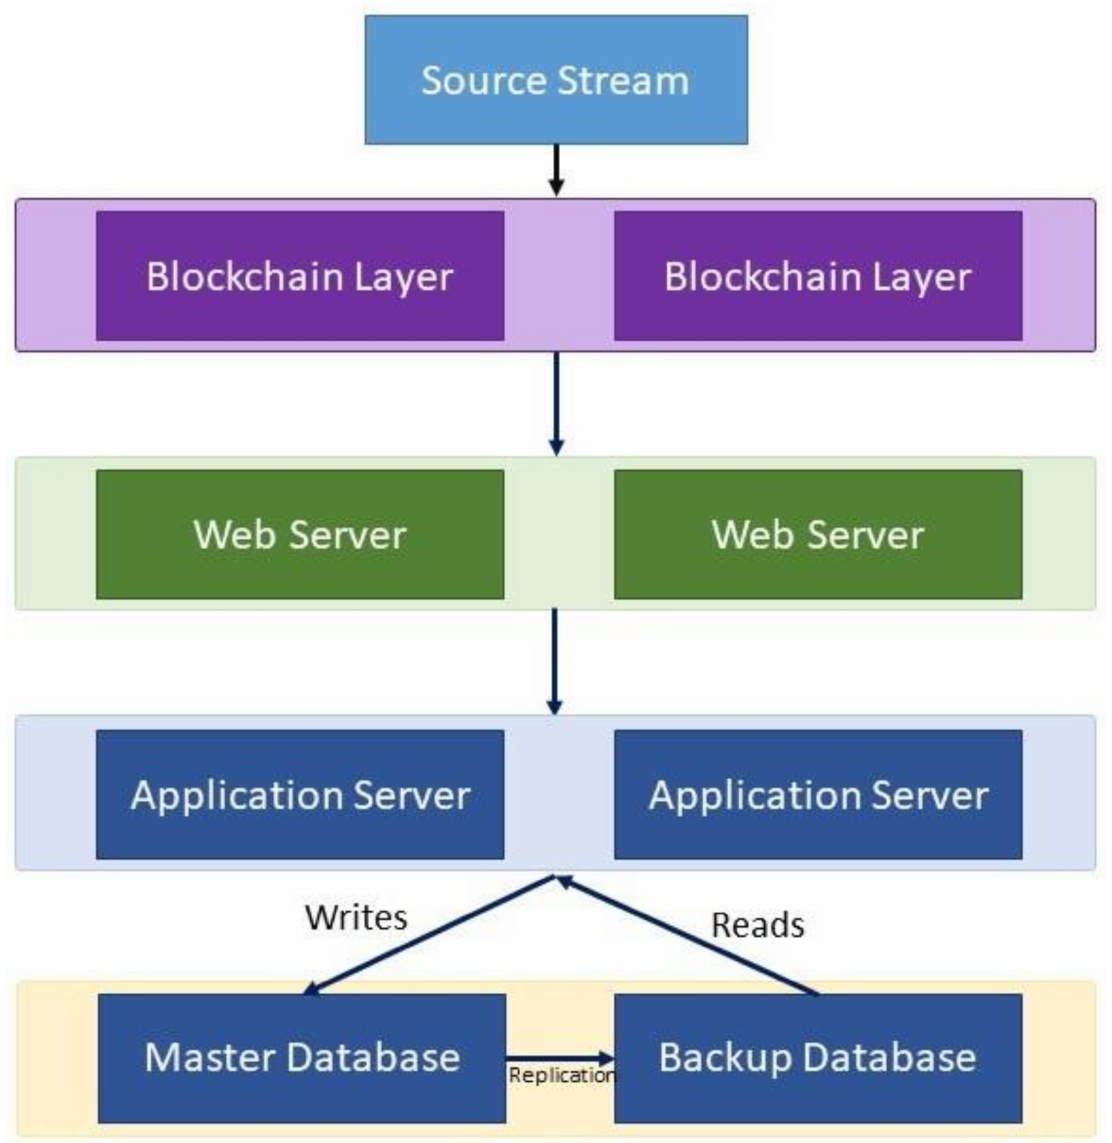
Figure 5. The proposed blockchain-based food tracking system architecture. With the proposed system, data will be obtained from the devices in the food tracking containers, and this data will be collected on the blockchain-based system. Food tracking will be carried out not only on the vehicle but at all stages of the supply chain. The distribution of the obtained data will be delivered to the end-user through the servers (Figure